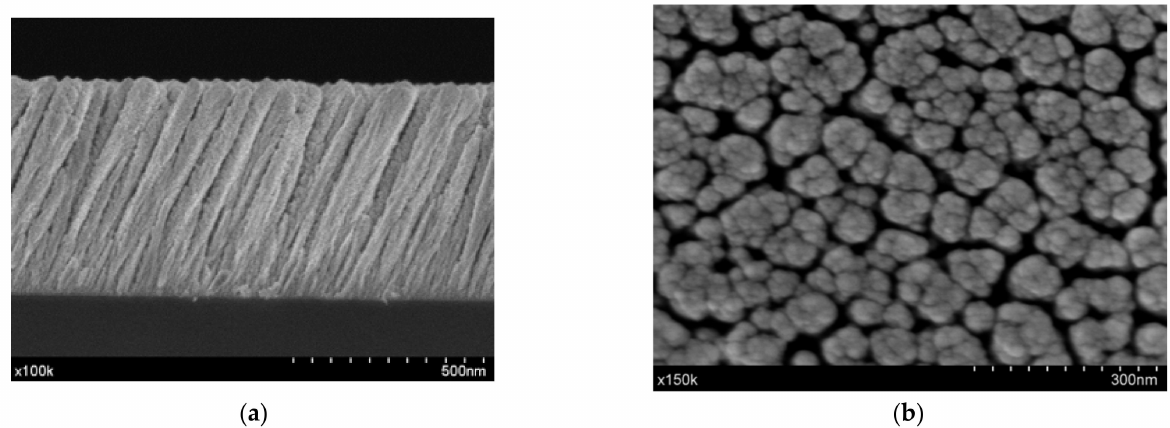
Figure 1. Scanning electron microscopy (SEM) microstructure images of nickel oxide (NiO) magnetron sputtering technique under an oblique angle deposition configuration (MS-OAD): cross-section ( a ) and top view ( b ).